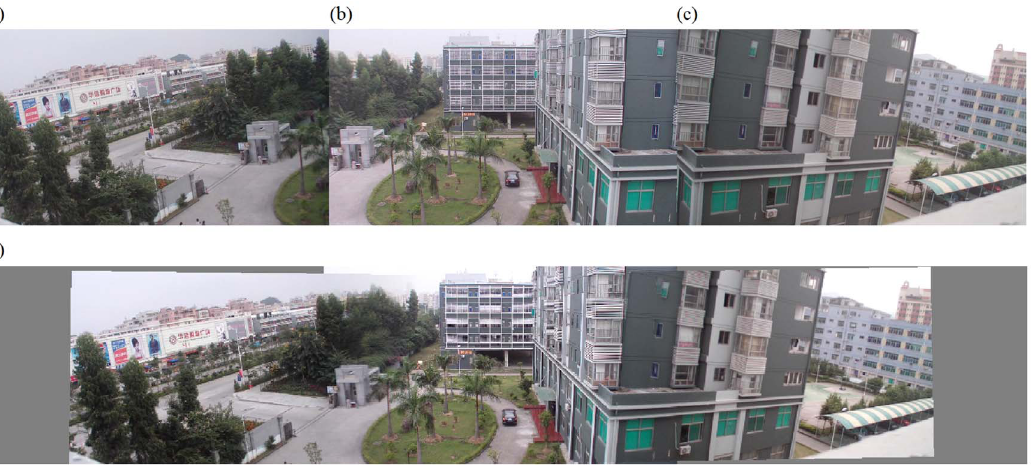
Figure 11. Experiments on the entire image-stitching algorithm (IV): (a) Video image 1; (b) Video image 2 (reference image); (c) Video image 3; (d) Generated video panoramic image.